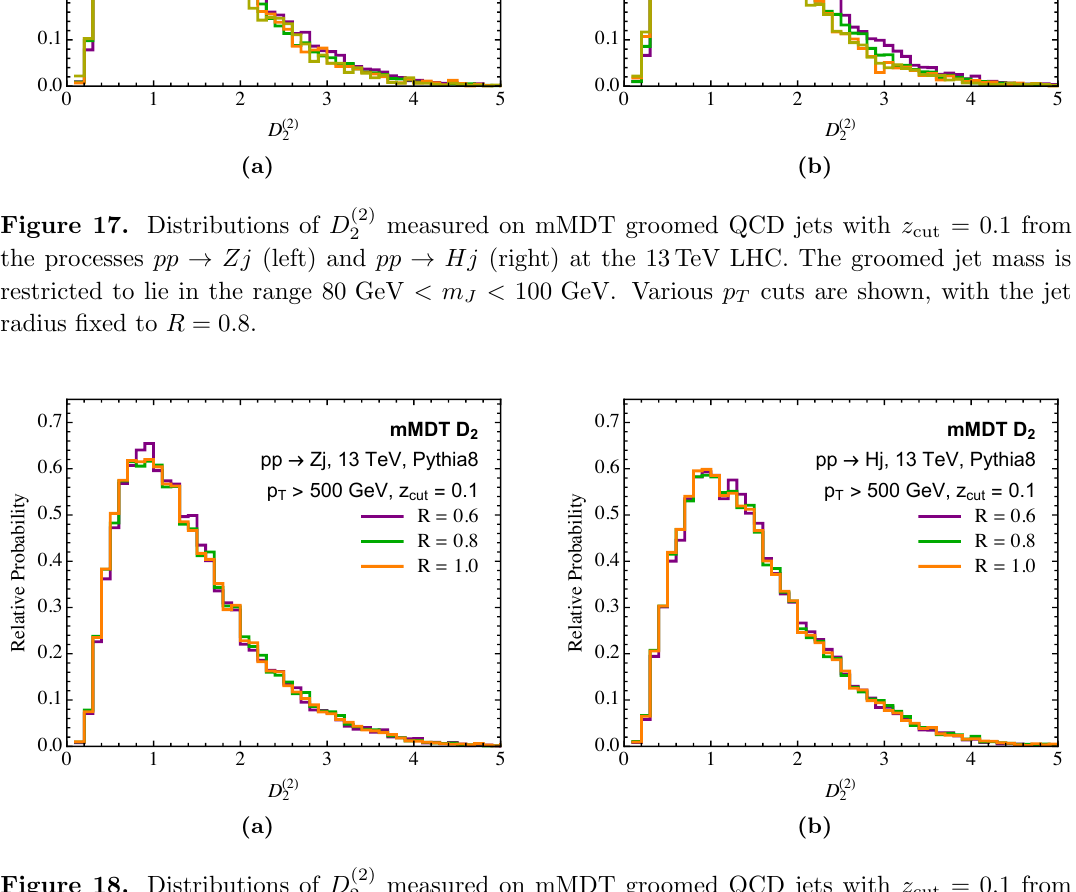
Figure 18. Distributions of D (2) measured on mMDT groomed QCD jets with z cut = 0 : 1 from 2 the processes pp Zj (left) and pp Hj (right) at the 13 TeV LHC. The groomed jet mass is ! ! restricted to lie in the range 80 GeV < m J < 100 GeV. Various jet radii R are shown, with the jet p T cut (cid:12)xed to p T > 500